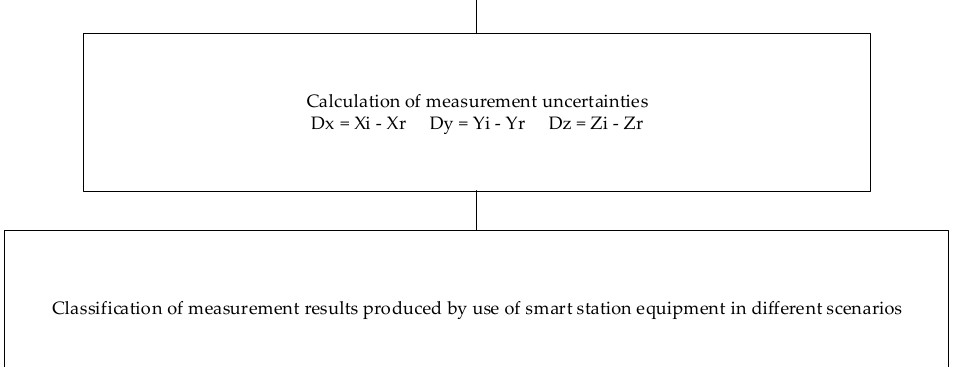
Figure 2. A diagram with the proposed approach and the evaluation parameters used in work.